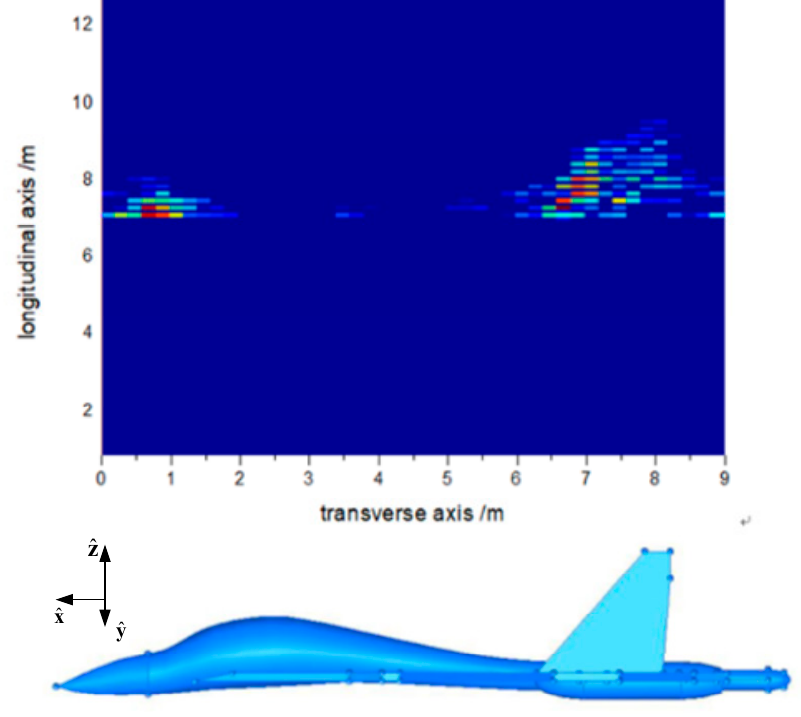
Figure 12. Aircraft model imaging by